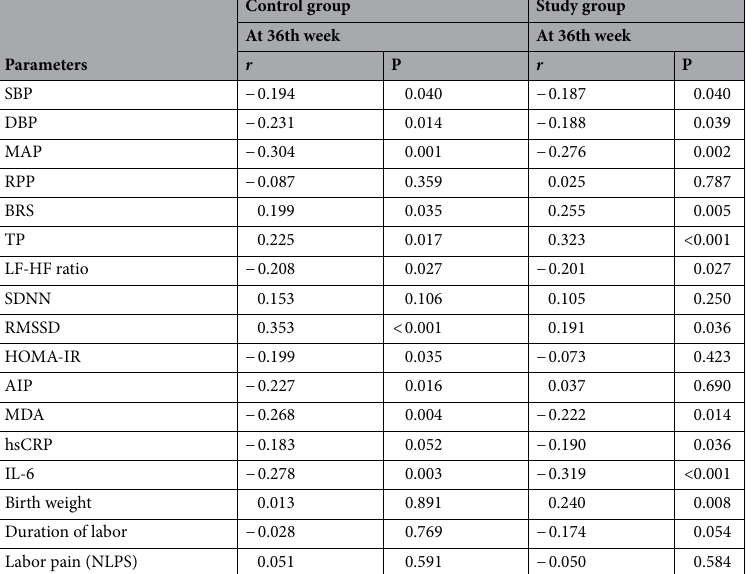
Table 6. Pearson correlation of nitric oxide with various parameters in women having risk factor for gestational hypertension in control group (n = 113) and study group (n = 121) at 36th week of gestation. The P value < 0.05 was considered significant, r correlation coefficient. SBP systolic blood pressure, DBP diastolic blood pressure, MAP mean arterial pressure, RPP rate pressure product, BRS baroreflex sensitivity, TP total power of HRV, LF-HF ratio of LF to HF, SDNN standard deviation of normal to normal (NN) interval, RMSSD square root of the mean of the sum of the squares of the differences between adjacent NN intervals, HOMA-IR homeostatic model assessment-Insulin resistance, AIP atherogenic index of plasma, MDA malondialdehyde, hsCRP high sensitive C-reactive protein, IL-6 interleukin-6, NPLS numeric labor pain